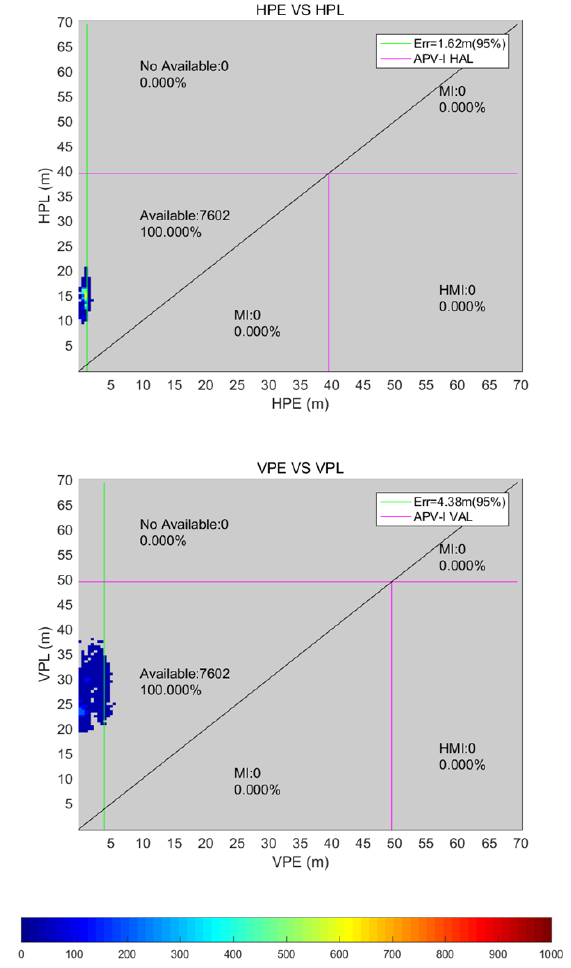
Figure 13. Stanford triangle charts for flight test-I. The top panel and the bottom panel are the horizontal Stanford chart and the vertical Stanford chart, respectively.